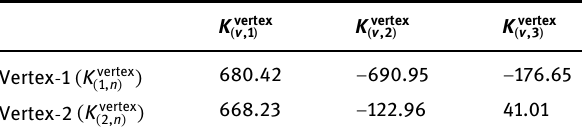
Table 4: The intensities of singularities at the vertices, ( ) K v n vertex ,